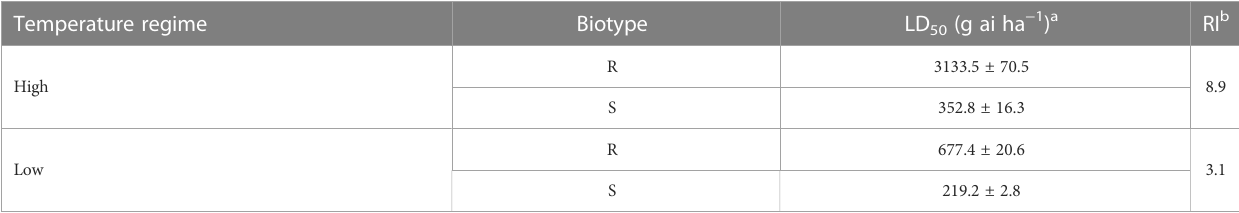
TABLE 1 Estimated LD 50 values in glyphosate-resistant (R) and -susceptible (S) Eleusine indica plants grown under high temperature (30°C/25°C day/ night) and low temperature (20°C/15°C day/night) regimes.